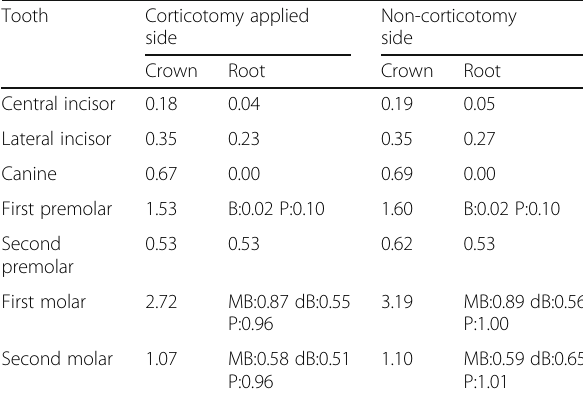
Table 3 The highest Von Mises stress levels calculated on the crowns and the roots of the